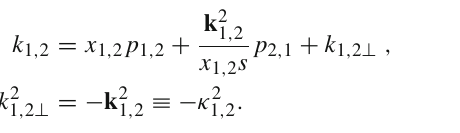
incoming partons are given in red, whereas the final-state hadron FFs arepictoricallyexpressedthroughthebordeauxarrowheads. a Mueller– Navelet jet channel. b Inclusive hadron-jet production. c Inclusive di- hadron